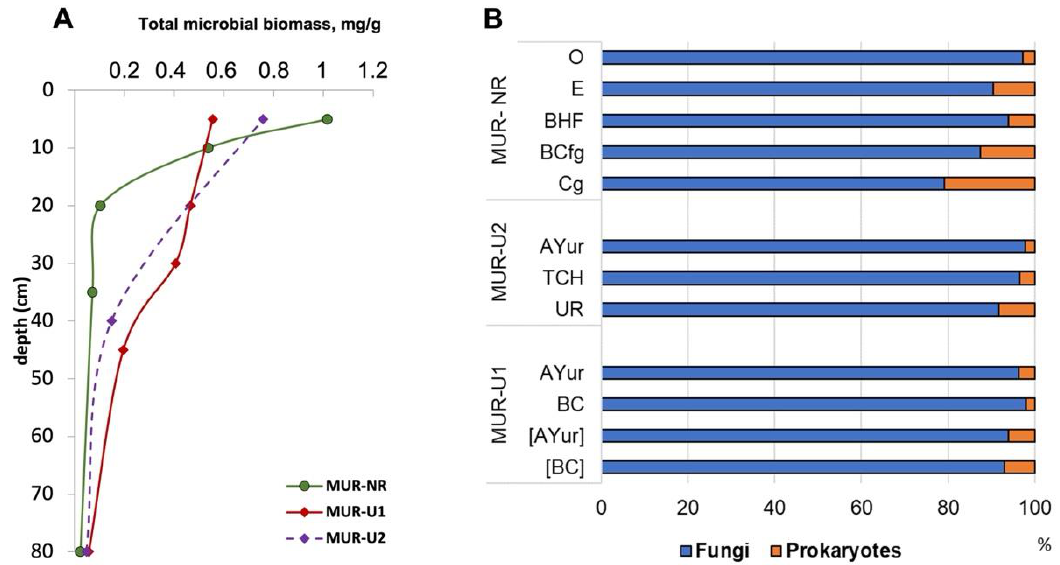
Figure 5. Profile distribution of the total microbial biomass ( A ) and fungi/ prokaryotes portion ( B ).